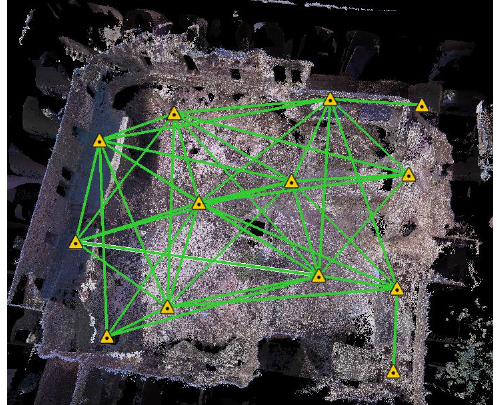
Figure 5. Cloud to cloud link error 0.013 m